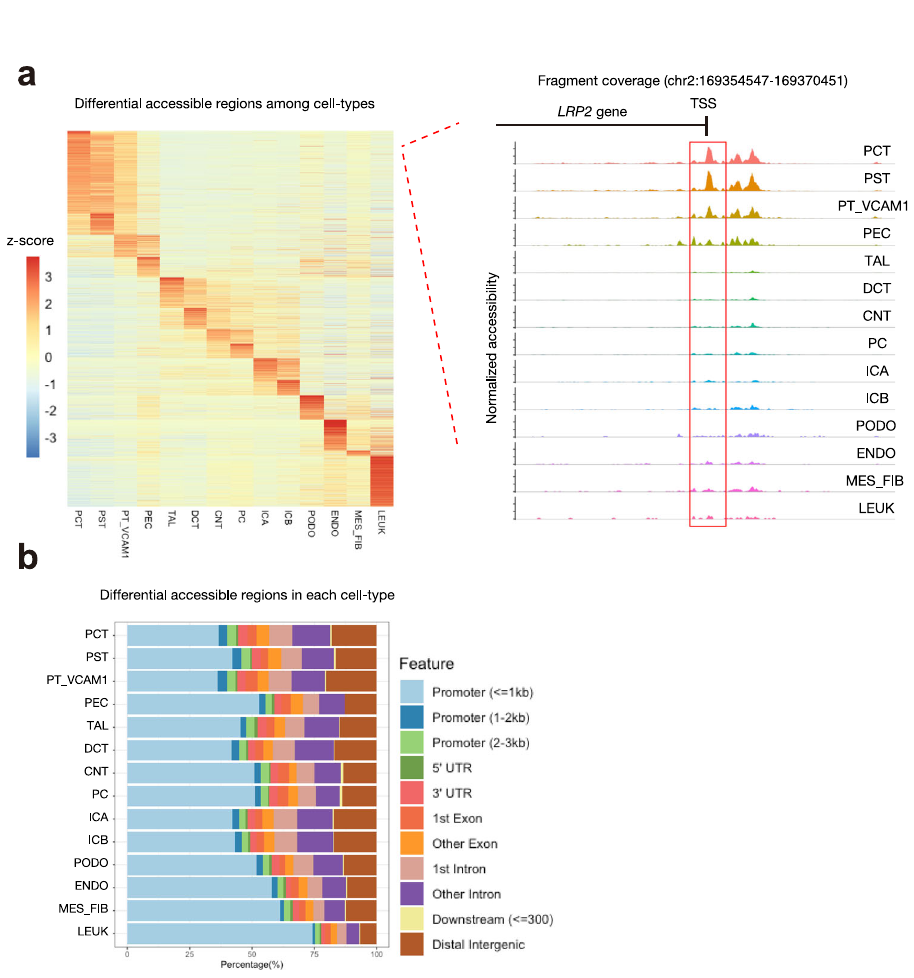
Fig. 2 Distribution of cell-type-speci fi c chromatin accessible regions. a Heatmap of average number of Tn5 cut sites within a differentially accessible region (DAR) for each cell type (left). The color scale represents a z-score of the number of Tn5 sites within each DAR scaled by row. Fragment coverage (frequency of Tn5 insertion) around the DAR (DAR ± 50 Kb) on the LRP2 gene promoter is shown (right). b Bar plot of annotated DAR locations for each cell